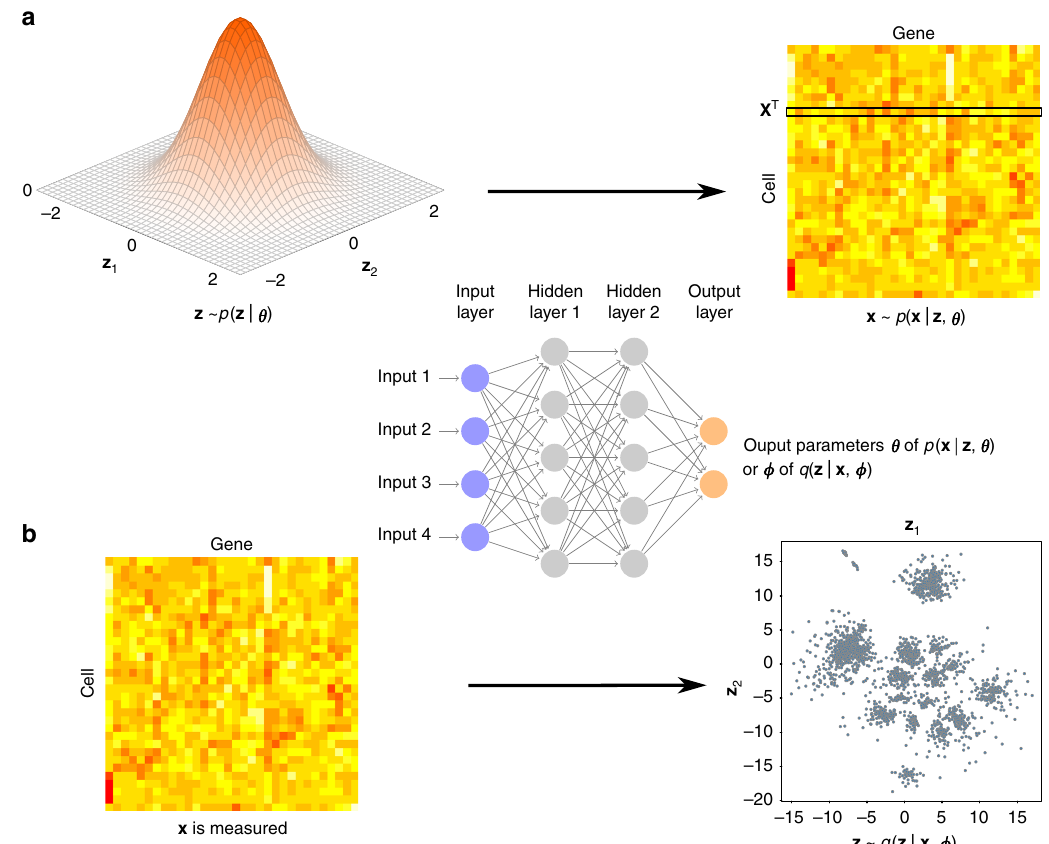
Fig. 1 Overview of the scvis method. a scvis model assumptions: given a low-dimensional point drawn from a simple distribution, e.g., a two-dimensional standard normal distribution, a high-dimensional gene expression vector of a cell can be generated by drawing a sample from the distribution p ( x | z , θ ). The heatmap represents a cell – gene expression matrix, where each row is a cell and each column is a gene. Color encodes the expression levels of genes in cells. The data-point-speci fi c parameters θ are determined by a model neural network. The model neural network (a feedforward neural network) consists of an input layer, several hidden layers, and an output layer. The output layer outputs the parameters θ of p ( x | z , θ ). b scvis inference: given a high- dimensional gene expression vector of a cell (a row of the heatmap), scvis obtains its low-dimensional representation by sampling from the conditional distribution q ( z | x , ϕ ). The data-point-speci fi c parameters ϕ are determined by a variational inference neural network. The inference neural network is also a feedforward neural network and its output layer outputs the parameters ϕ of q ( z | x , ϕ ). Again, the heatmap represents a cell – gene expression matrix. The scatter plot shows samples drawn from the variational posterior distributions q ( z | x , ϕ